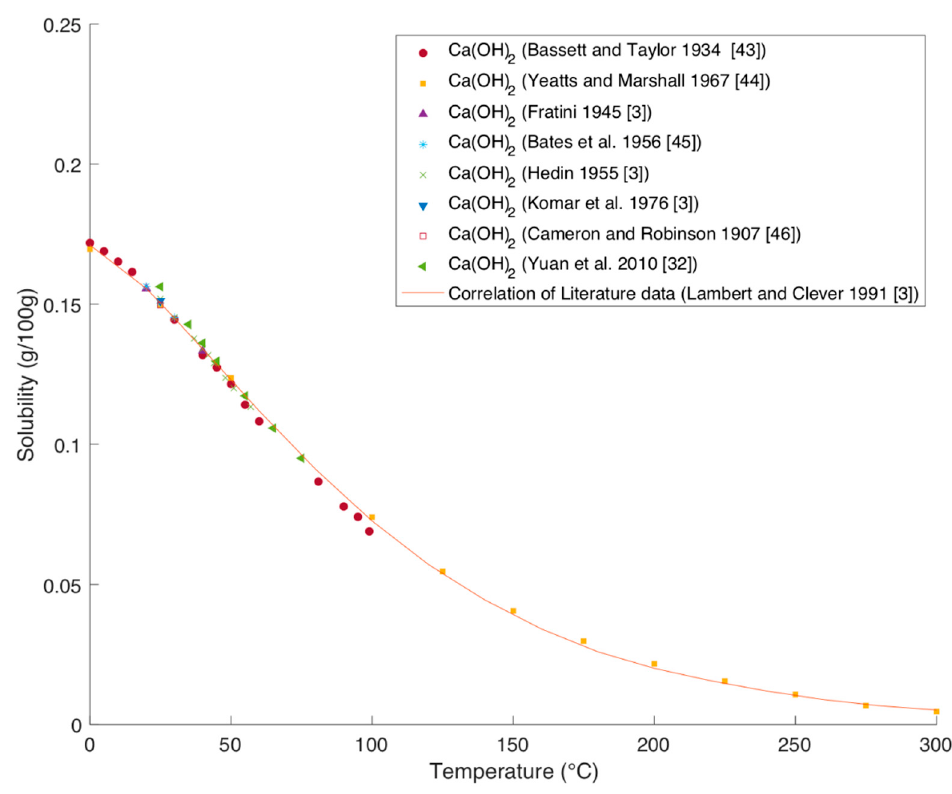
Figure 12. Solubility of Ca(OH) 2 in water [3,32,43–46]. The data from Fratini (1945), Hedin (1955), and Komar et al. (1976) were taken